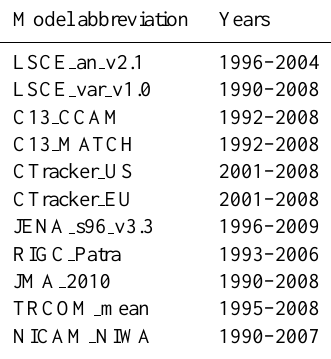
Table 1. RECCAP atmospheric inversions included in this